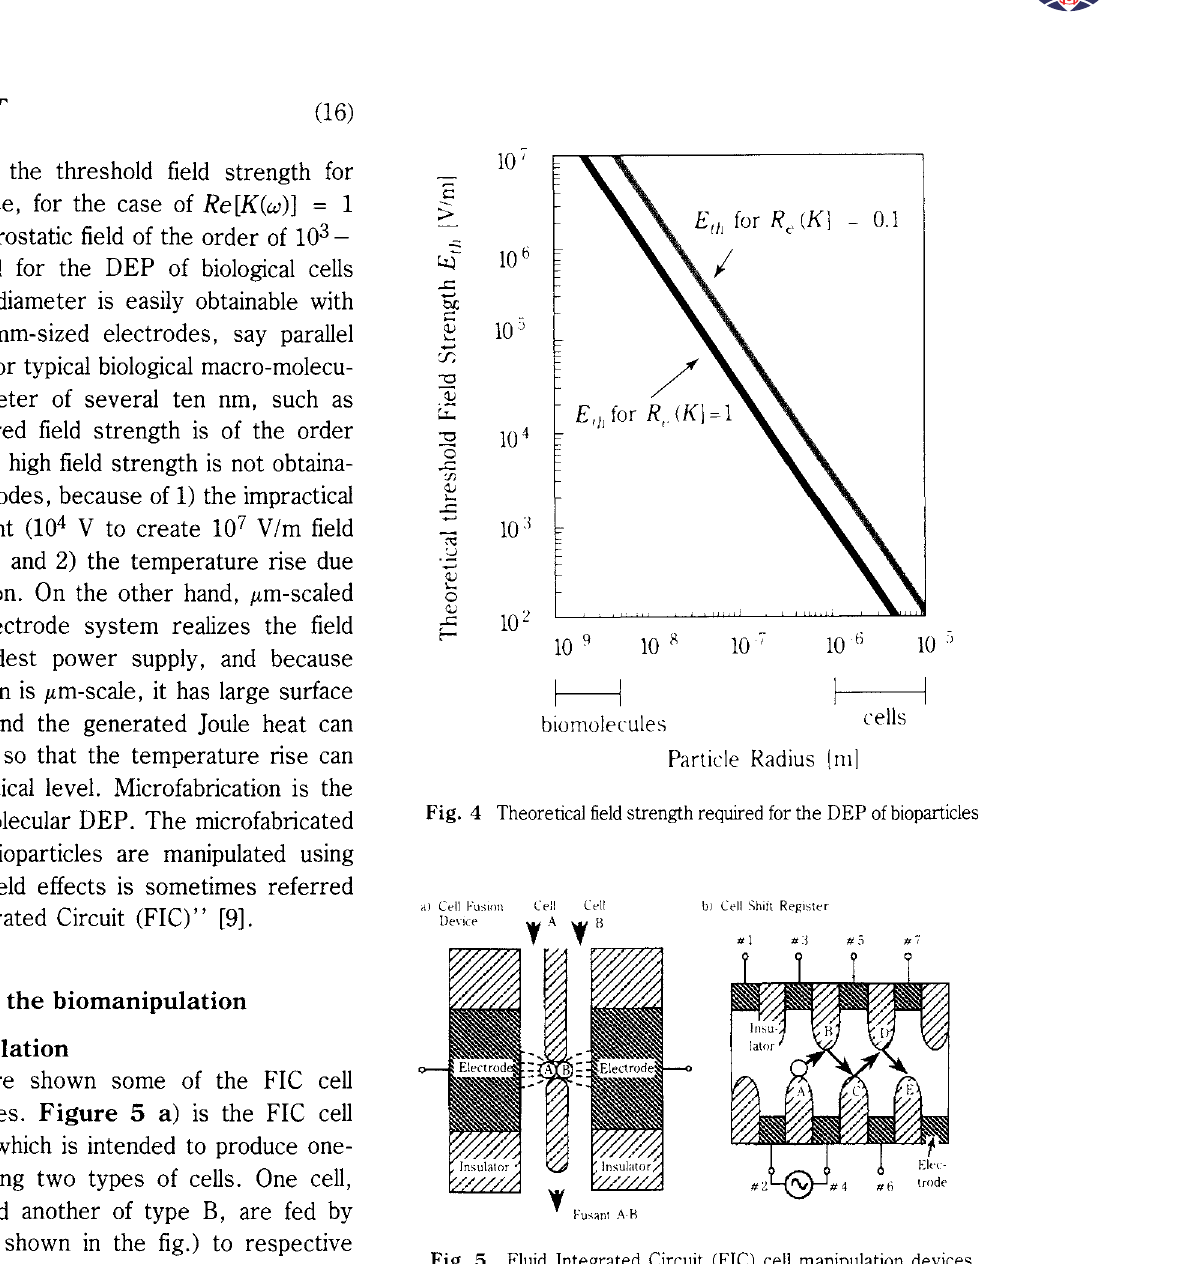
Fig. 4 Theoretical field strength required for the DEP of bioparticles